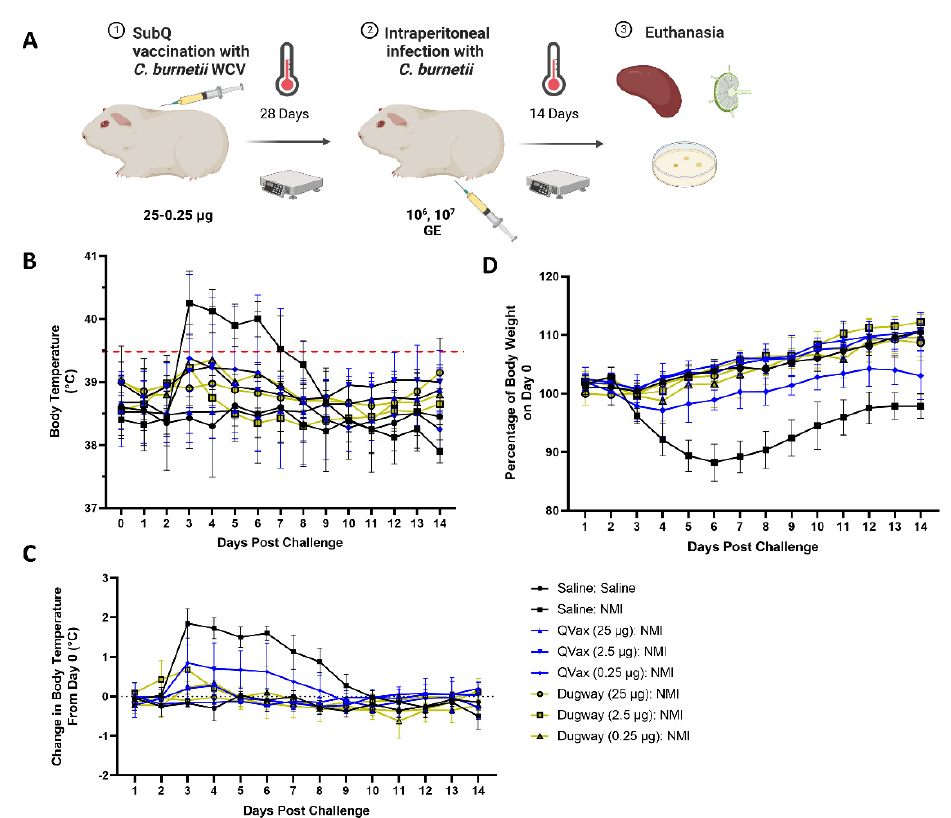
Figure 2. C. burnetii Dugway whole-cell vaccine exhibits heterologous protection against fever and body weight loss. The guinea pig vaccine-challenge model is outlined in ( A ). Body temperatures ( B ), body temperature change ( C ), and body weight change ( D ) kinetics are displayed for 14 days following infection.